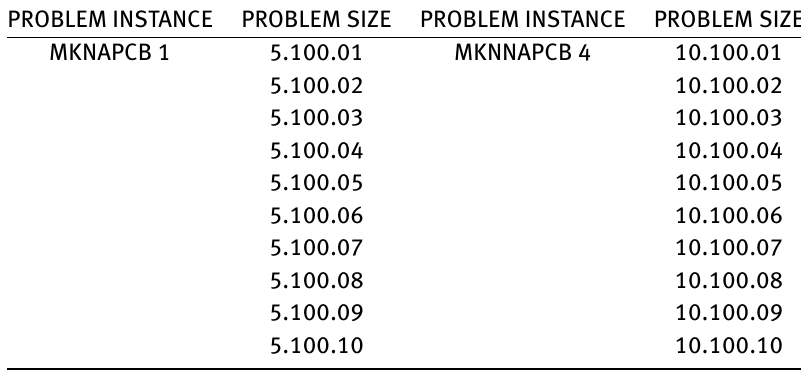
Table 3: Characteristics of MKNAPCB 1 and MKNAPCB 4 instances